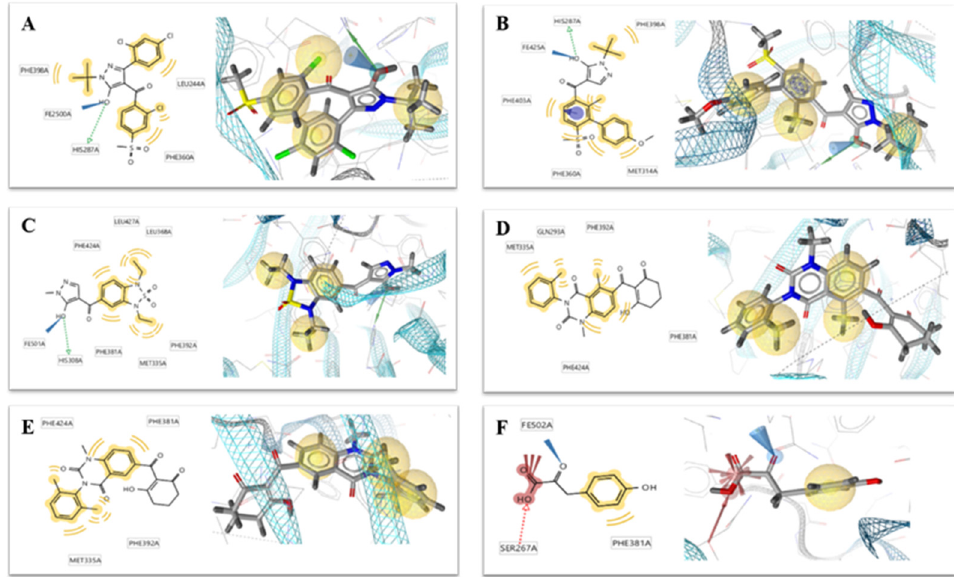
Figure 2. Two-dimensional (left) and 3D (right) charts of structure-based pharmacophore models ( A ) 1TG5, ( B ) 1TFZ, ( C ) 5YWH, ( D ) 5YWK, ( E ) 5YY6 and ( F ) 5XGK for potential 4-hydroxyphenylpyruvate dioxygenase (HPPD) inhibitors in the HPPD binding pocket. The interactions were visualized with the following color code: hydrogen bond acceptor (red arrow), hydrogen bond donor (green arrow), hydrophobic interaction (yellow sphere), aromatic ring feature interaction (purple sphere and arrow).